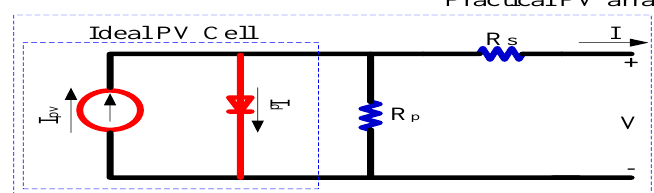
Figure 1. The equivalent model of PV cell.